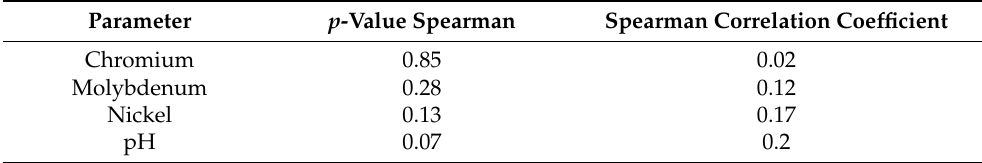
Table 5. A Spearman correlation test on the uniform corrosion